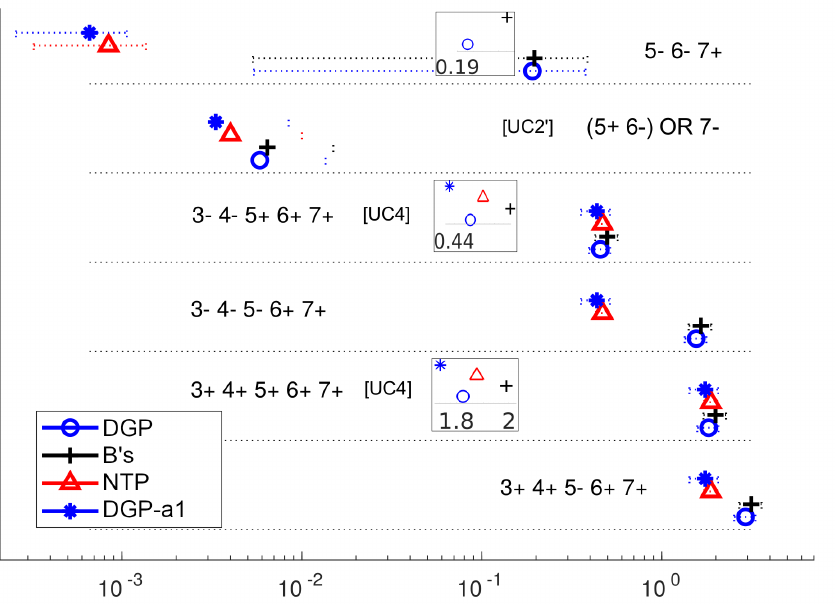
Figure A9. The six distinctive behaviours found in all scenarios for M 12 ( β R − uncert ) when α R = 1, with logarithmic x axis and zoom in some behaviours for better showing the methods differences. Axes 3 and 4 are always in the same extreme position.